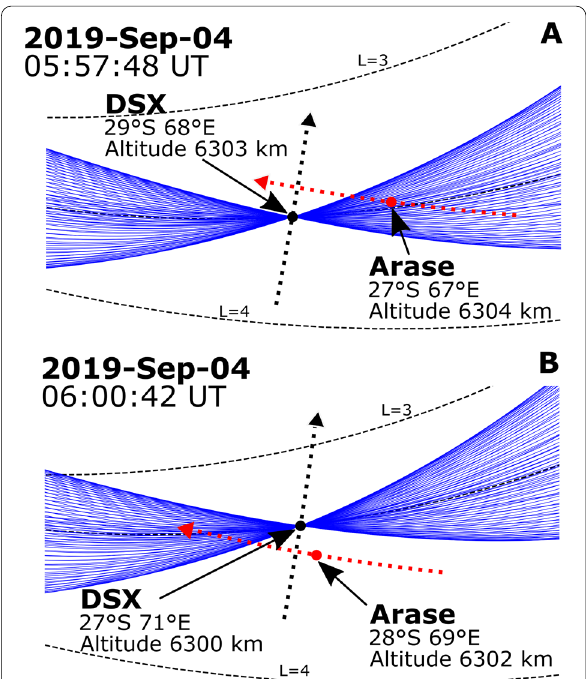
Fig. 2 Spatial configuration of DSX–Arase transmission event at A 05:57:48 UT, closest approach of Arase to the DSX magnetic field line, and B 06:00:42 UT, closest spatial approach of Arase and DSX. DSX location and direction of motion are indicated by the black dot and dotted arrow, respectively, and the same for Arase are indicated in red. Geomagnetic field lines are shown as black dashed lines. Direct VLF ray paths are shown in blue